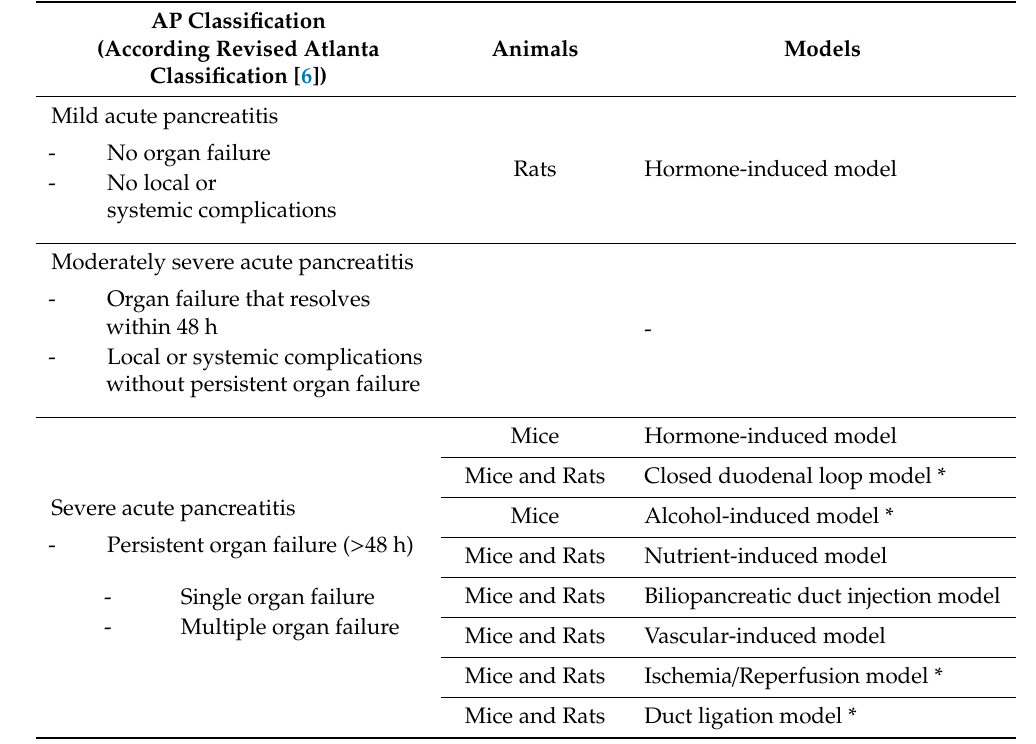
Table 1. Animal models for acute pancreatitis according to the severity